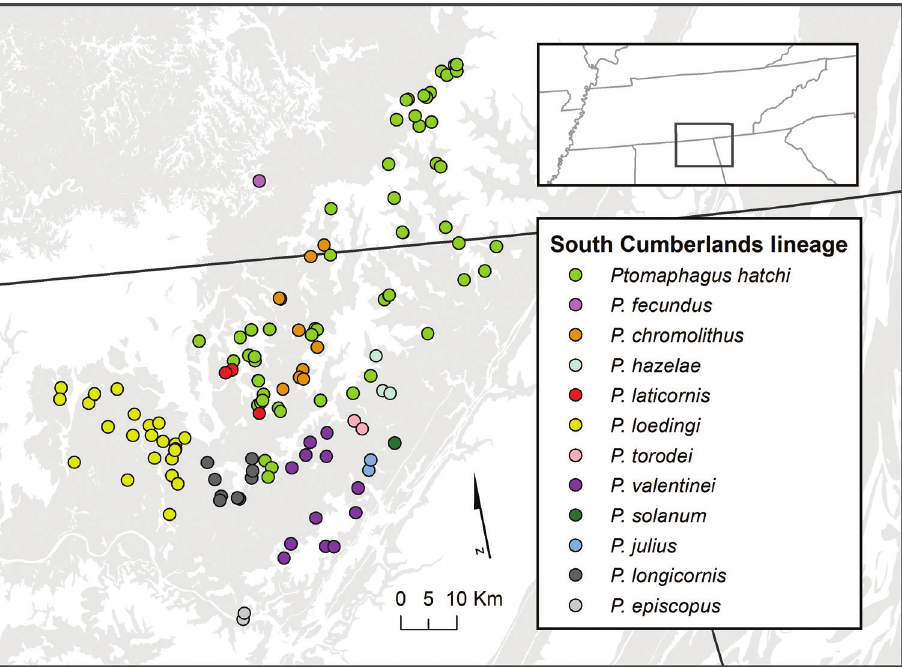
Figure 2B. Distribution of hirtus -group species. All known sites for members of the South Cumberlands lineage in Tennessee and Alabama. Exposed karst is shown in